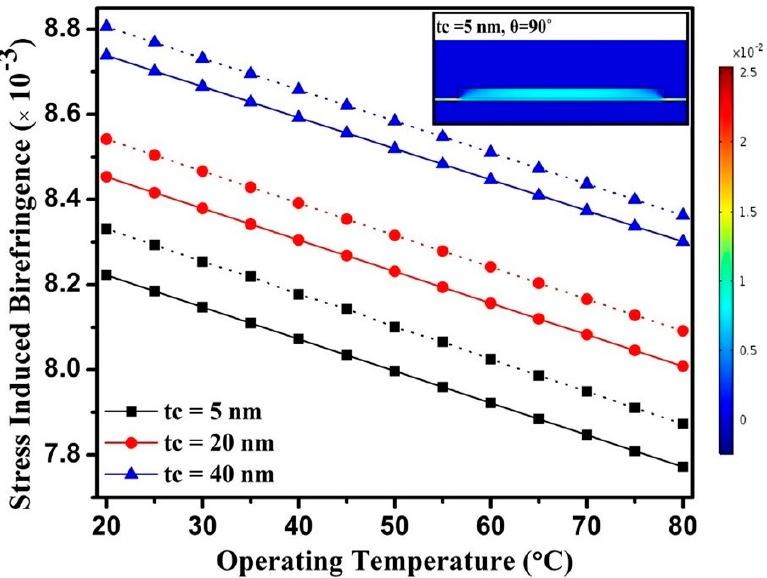
Figure 4. Operating temperature influence on birefringence for rectangular ( θ = 90°, solid line) and trapezoidal ( θ = 110°, dashed line) ridge waveguides for different cladding thicknesses.